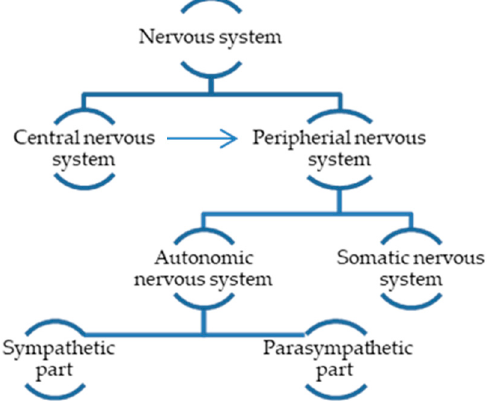
Figure 2. Classification of the nervous system.